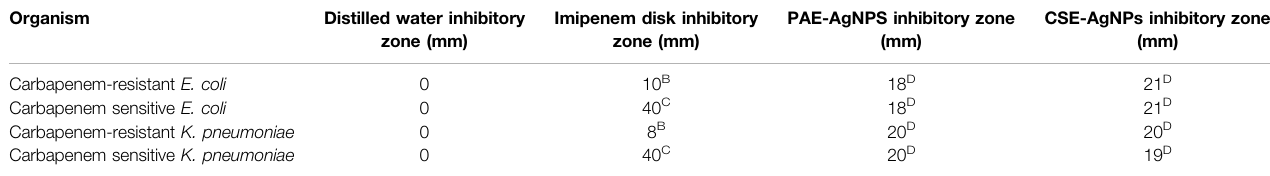
Imipenem disk inhibitory PAE-AgNPS inhibitory zone CSE-AgNPs inhibitory zone zone (mm) zone (mm) (mm) (mm)